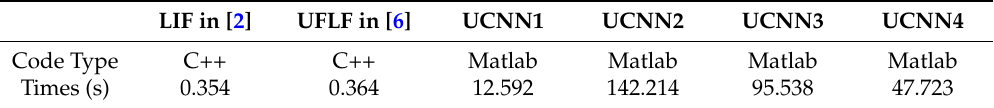
Table 14. Feature extraction times of different single features per one image scene.